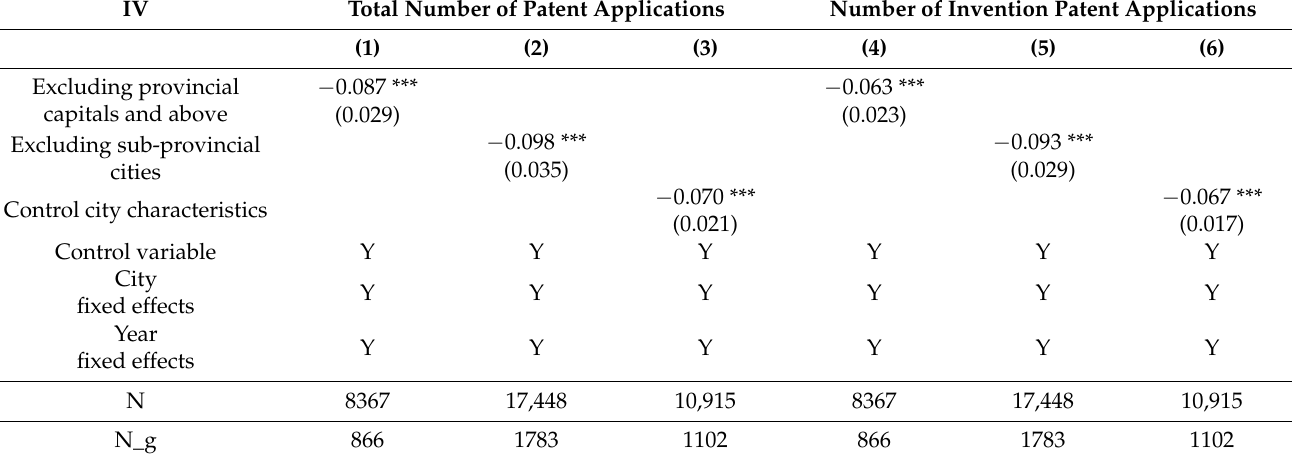
Table 6. Robustness test (3).